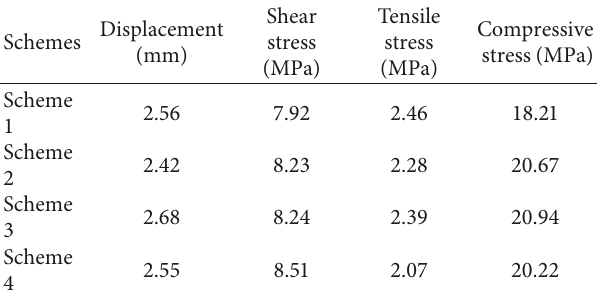
Table 3: Roof displacement and stress values of the four schemes after the third step.